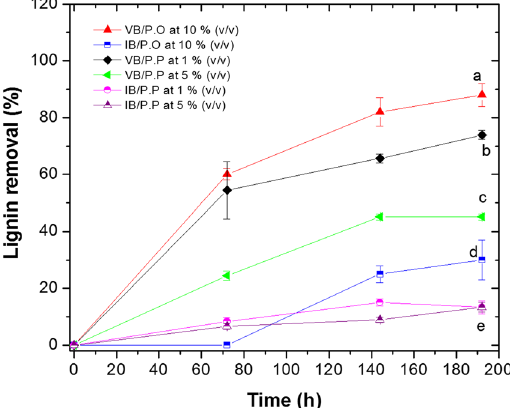
Figure 3. Lignin removal for P. ostreatus viable biomass (VB/P.O), inactive biomass (IB/P.O), P. pastoris VB/P.P and IB/P.P with 10%, 5%, and 1% (v/v) SBL. Lignin removal was observed for both microorganisms, reaching levels of 88% for 10% (v/v) SBL with P. ostreatus and 73% for 1% (v/v) SBL with P. pastoris . The removal by adsorption for both cases ranged between 13 and 30%. The letters represent heterogeneous groups